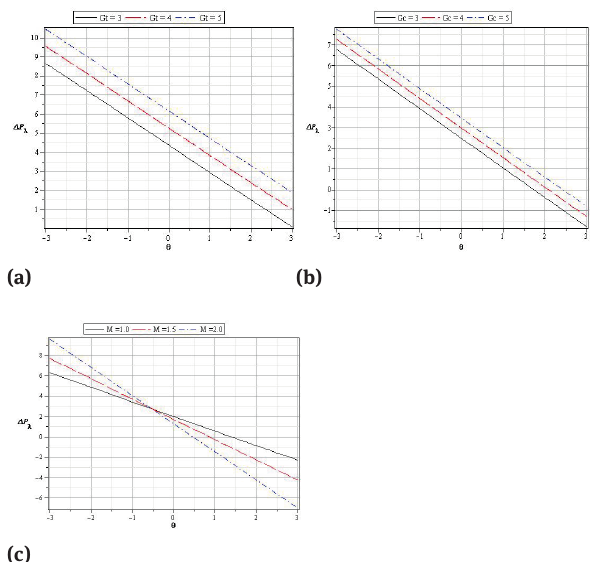
Fig. 1: Pressure rise ΔP λ versus θ for (a): M = 1, Gc = 5, A